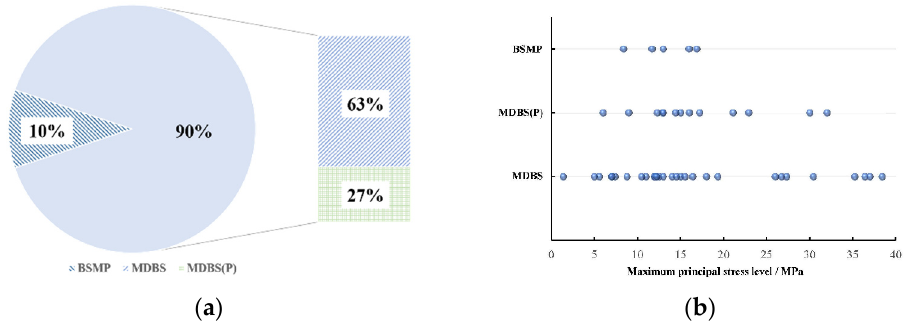
Combined with powerhouses in Table 1, the excavation procedures and the key design parameters used in the top arch zone were further summarized and plotted in Figure 10.